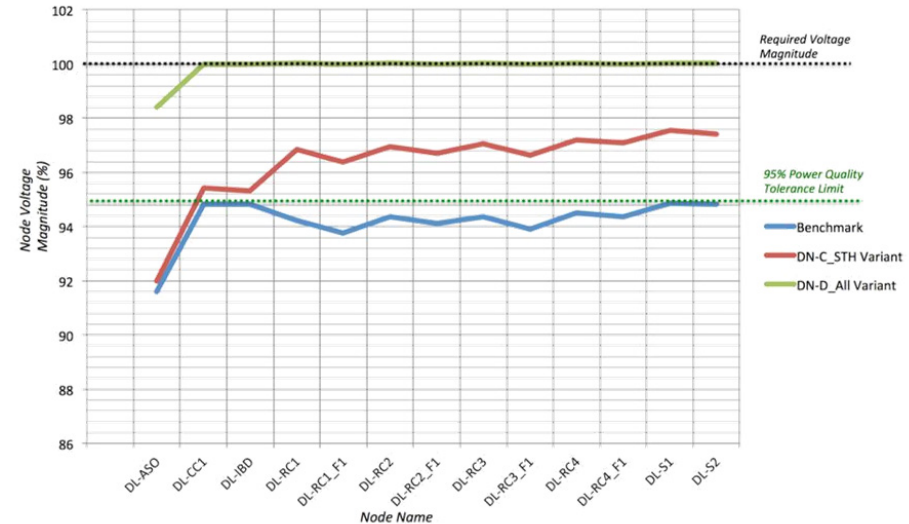
Figure 8. Graphical Representation of Relative Improvement in Voltage Magnitude between Top Centralized and Top Distributed ESS Integration Architecture Variants.